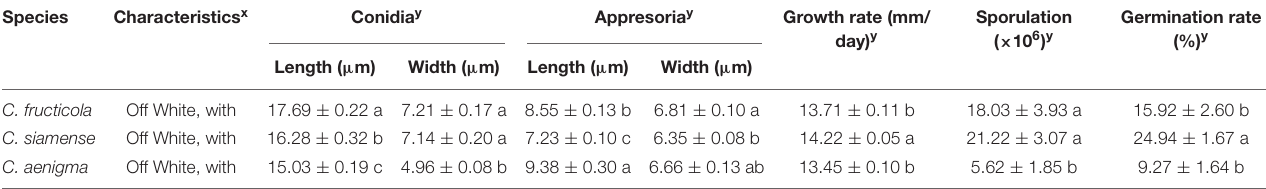
TABLE 2 | Size of spore, appresoria, hyphae growth rates, sporulation and spore germination rate of different Colletotrichum species from strawberry.